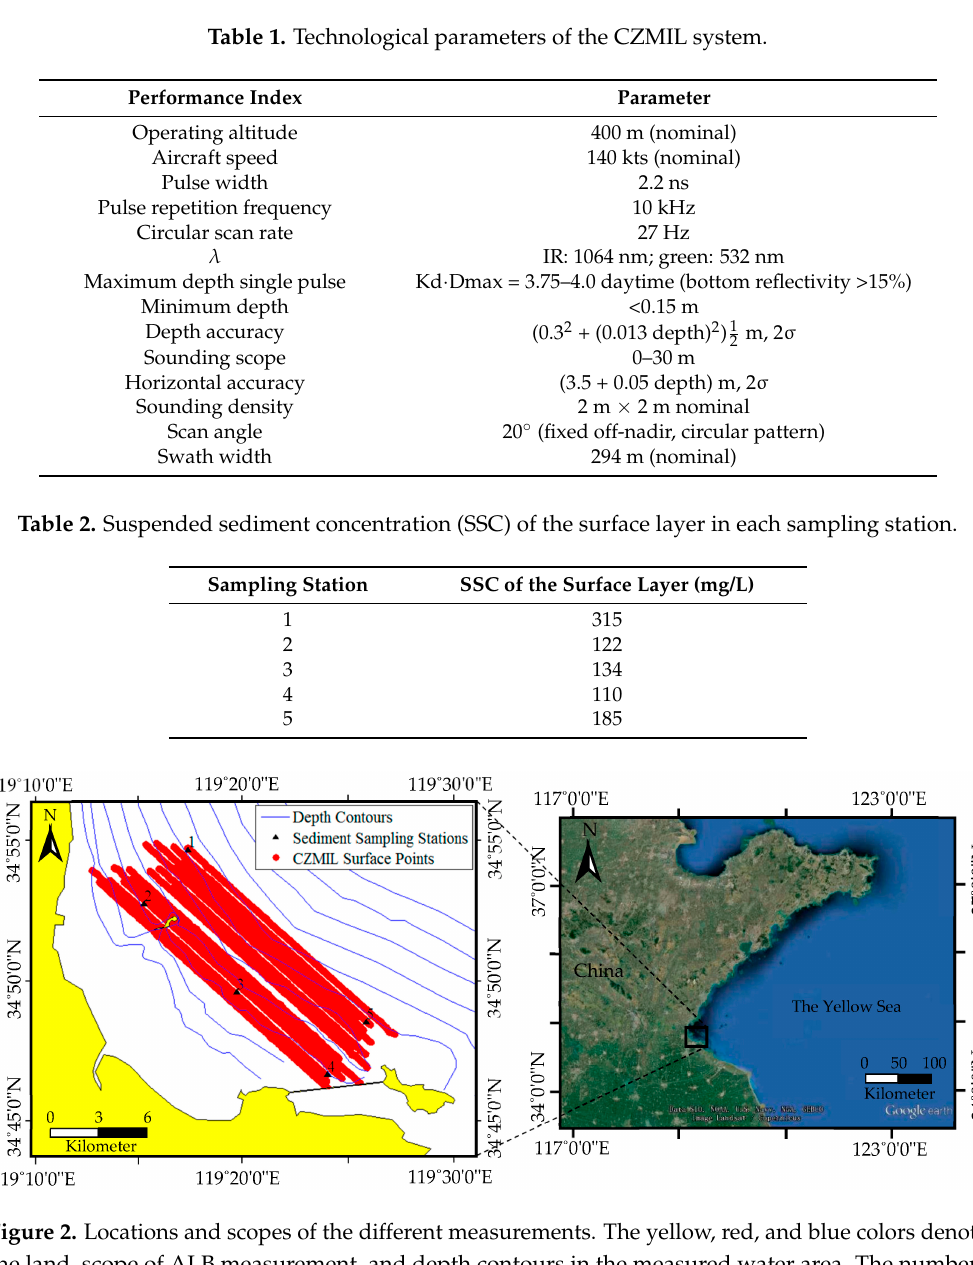
Table 3. Statistical parameters of the four-type data used in the modeling. SSC of the Surface Layer C (mg/L)